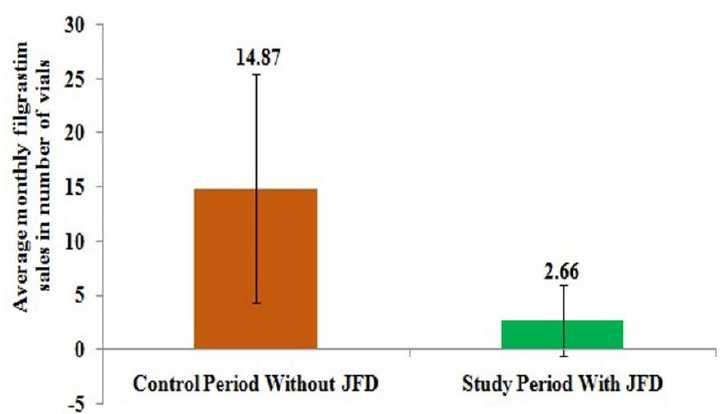
Figure 2. Average monthly sales quantity in vials for filgrastim from hospital pharmacy.